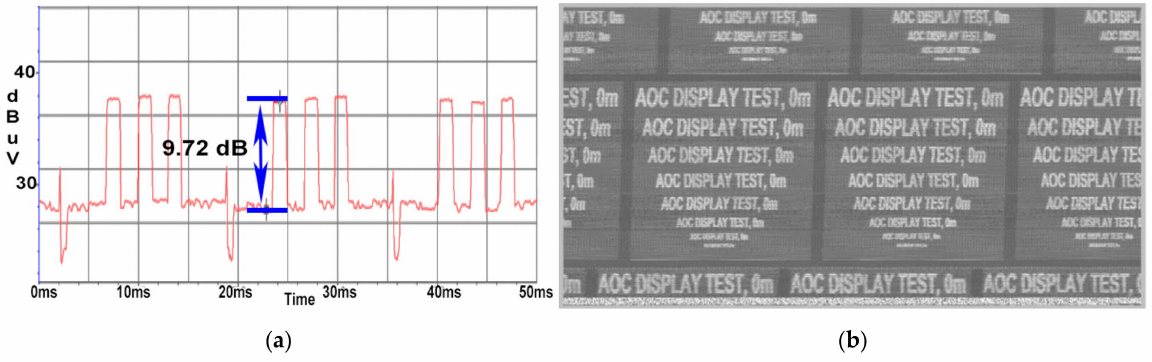
Figure 10. AOC display: ( a ) SNR measured at a distance of 0 m; ( b ) image recovered at a distance of 0